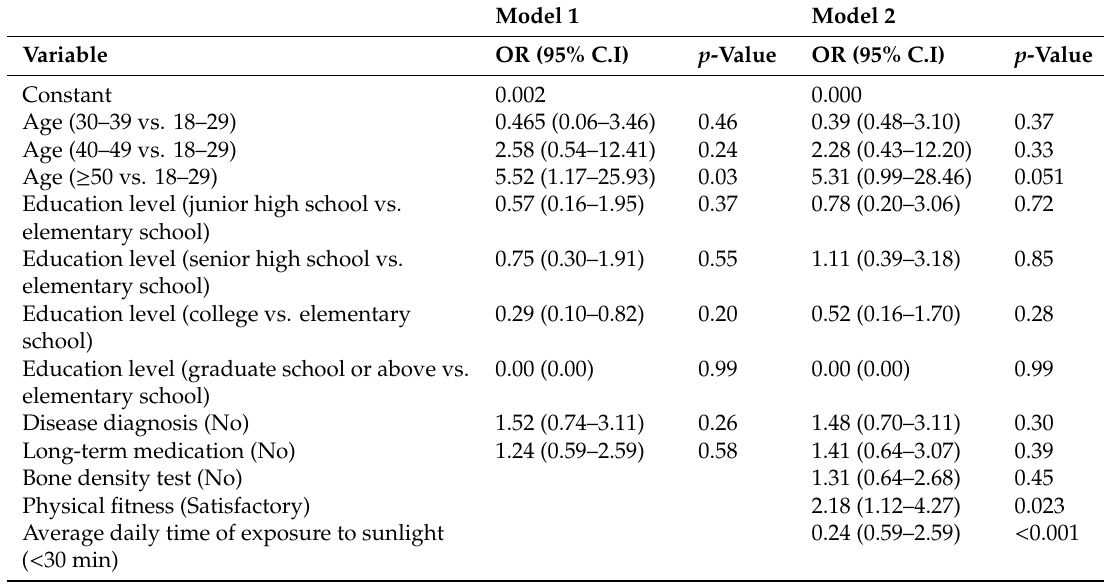
Table 7. Logistic regression analysis of osteoporosis risk factors (n =